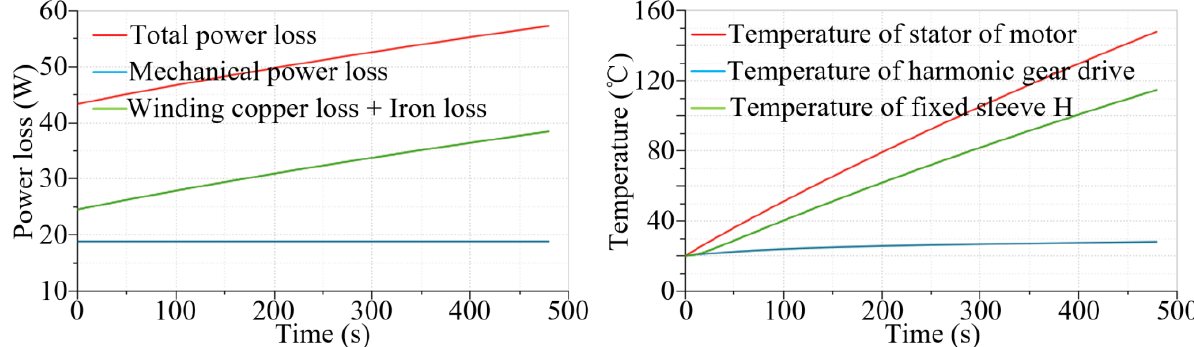
Figure 13. Variation of power loss and temperature over time (without the heat-conducting shell).